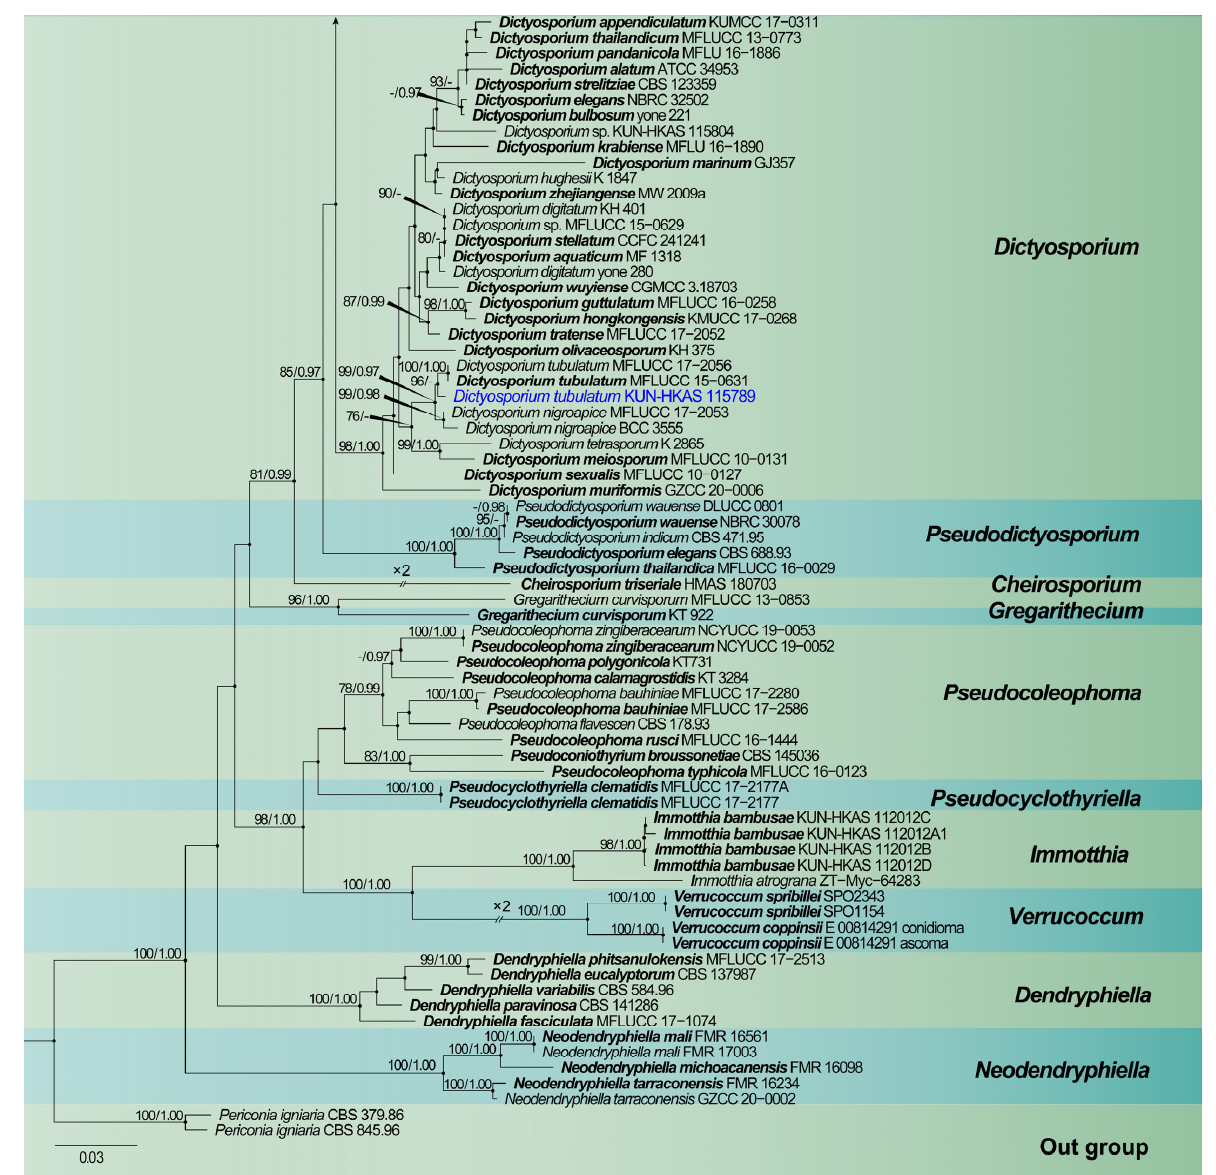
Figure 1. The maximum likelihood (ML) tree is based on the combined SSU, ITS, LSU and tef 1- α sequence data. Bootstrap support values with an ML greater than 75% and Bayesian posterior probabilities (PP) greater than 0.97 are given above the nodes, shown as “ML/PP”. The tree was rooted to Periconia igniaria (CBS 379.86 and CBS 845.96). New species are indicated in blue and type strains are in bold.